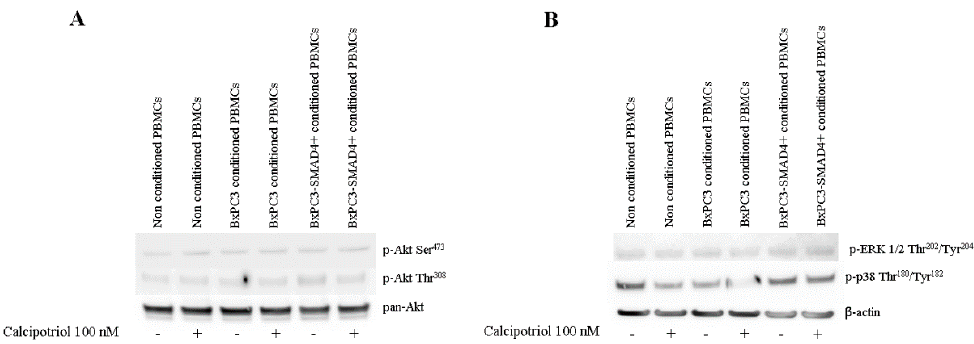
Figure 4. Western blot analyses obtained from PBMCs cultured or not cultured with BxPC3 or BxPC3- SMAD4+ conditioned media in the presence or in the absence of 100 nM calcipotriol. Representative targets of the PI3K/AKT (panel A ), ERK and p-38 (panel B ) pathways are shown.